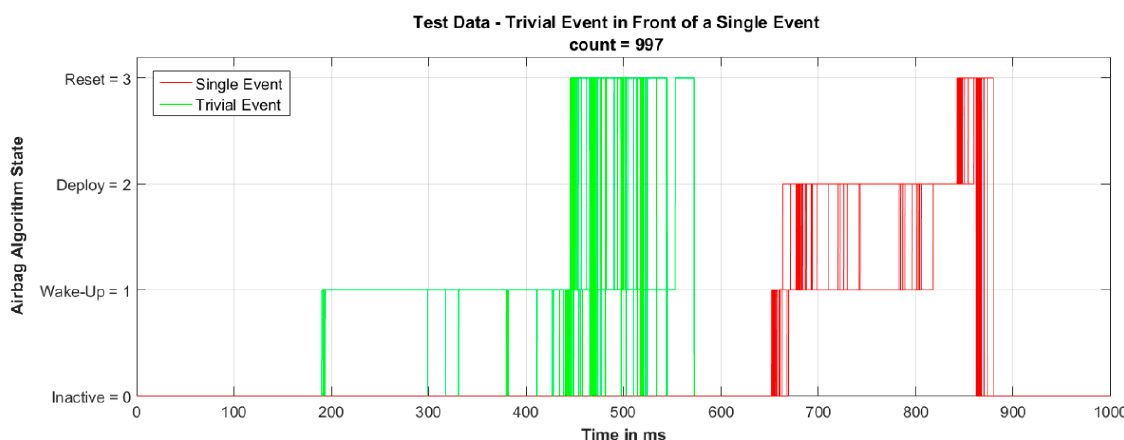
Figure 15. Case 1—Single event: overview of all generated test input data at “target reached”.